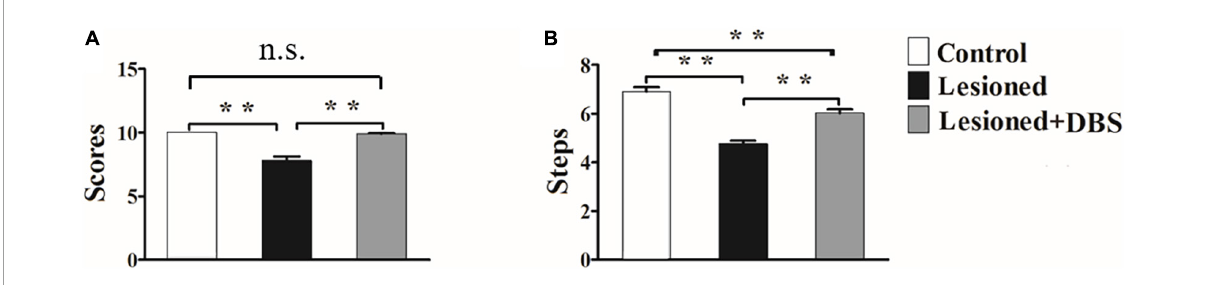
FIGURE2 Results of the vibrissae-evoked forelimb placing test (A) and adjusting-steps test (B) in rats in the control group ( n = 6), 6-OHDA-lesioned group ( n = 7), and 6-OHDA-lesioned + DBS treatment ( n = 8) group. ** p < 0.01.